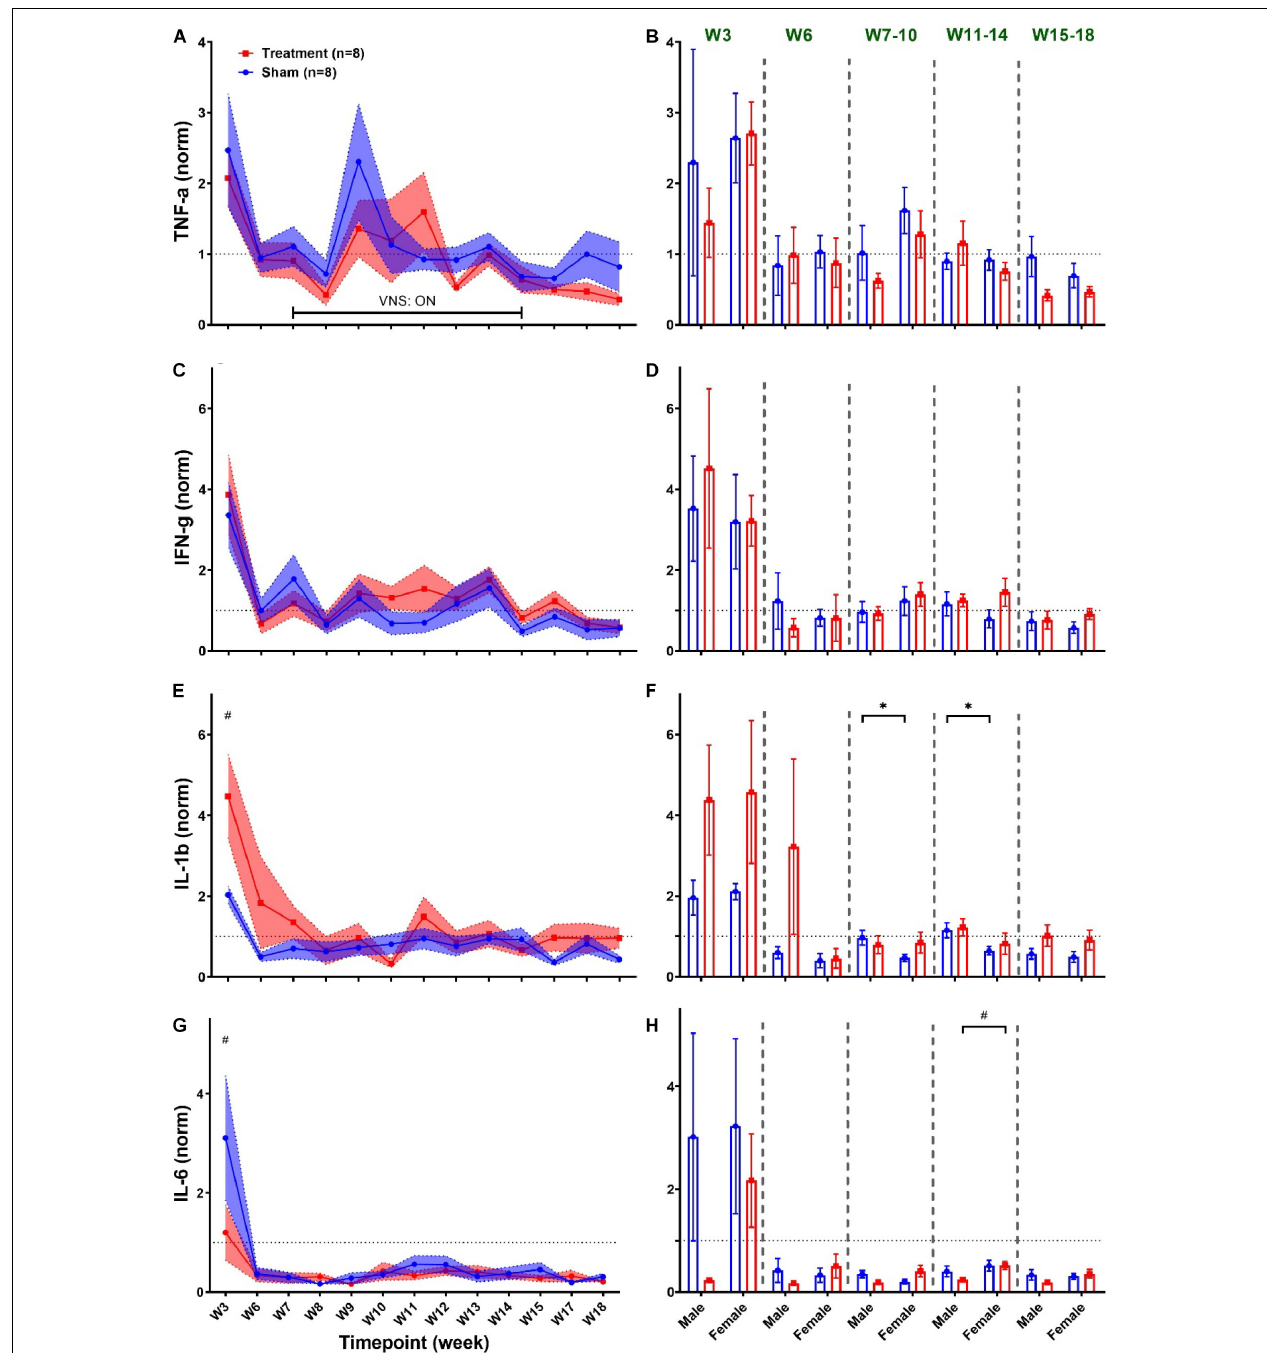
FIGURE 9 | Weekly concentration of plasma cytokines normalized to the baseline during different experimental timepoints (mean ± SEM). (A,B) TNF- α increases by almost four-fold in both Treatment and Sham groups after implantation of the ECG device on W3 with no consistent trend or significant change by the VNS. Male–female comparison does not reveal any significant effects or sex differences during the five independent phases. (C,D) IFN- γ elevates by the VNS in all rats and then quickly recovers and remains unchanged without significant differences between the Treatment and Sham groups. Male–female comparison does not reveal any significant effects or sex differences during the five independent phases (E,F) IL-1 β significantly increases in the Treatment group after the first surgery and then recovers within two weeks and remains unchanged without any difference compared to the Sham group. Male–female difference was only found in the Sham group during the VNS_Early and VNS_Late phases. (G,H) IL-6 significantly increases in the Sham group after the first surgery and then sharply falls below the baseline level at a comparable range as Treatment group with no significant difference. Male–female comparison reveals significant difference in Treatment during the VNS_Late phase. * p < 0.05 and # p <